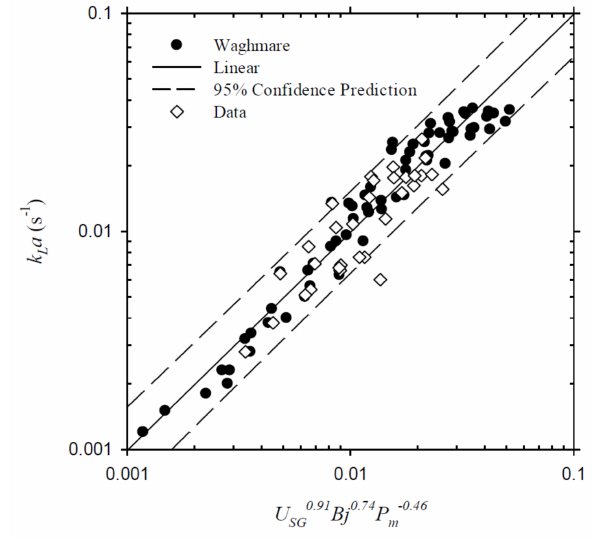
Figure 20. Regression Correlation of Waghmare et al. [19] data and results of the present